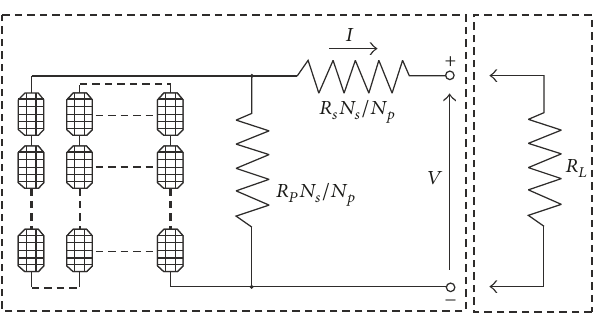
Figure 3: The PV module equivalent circuit